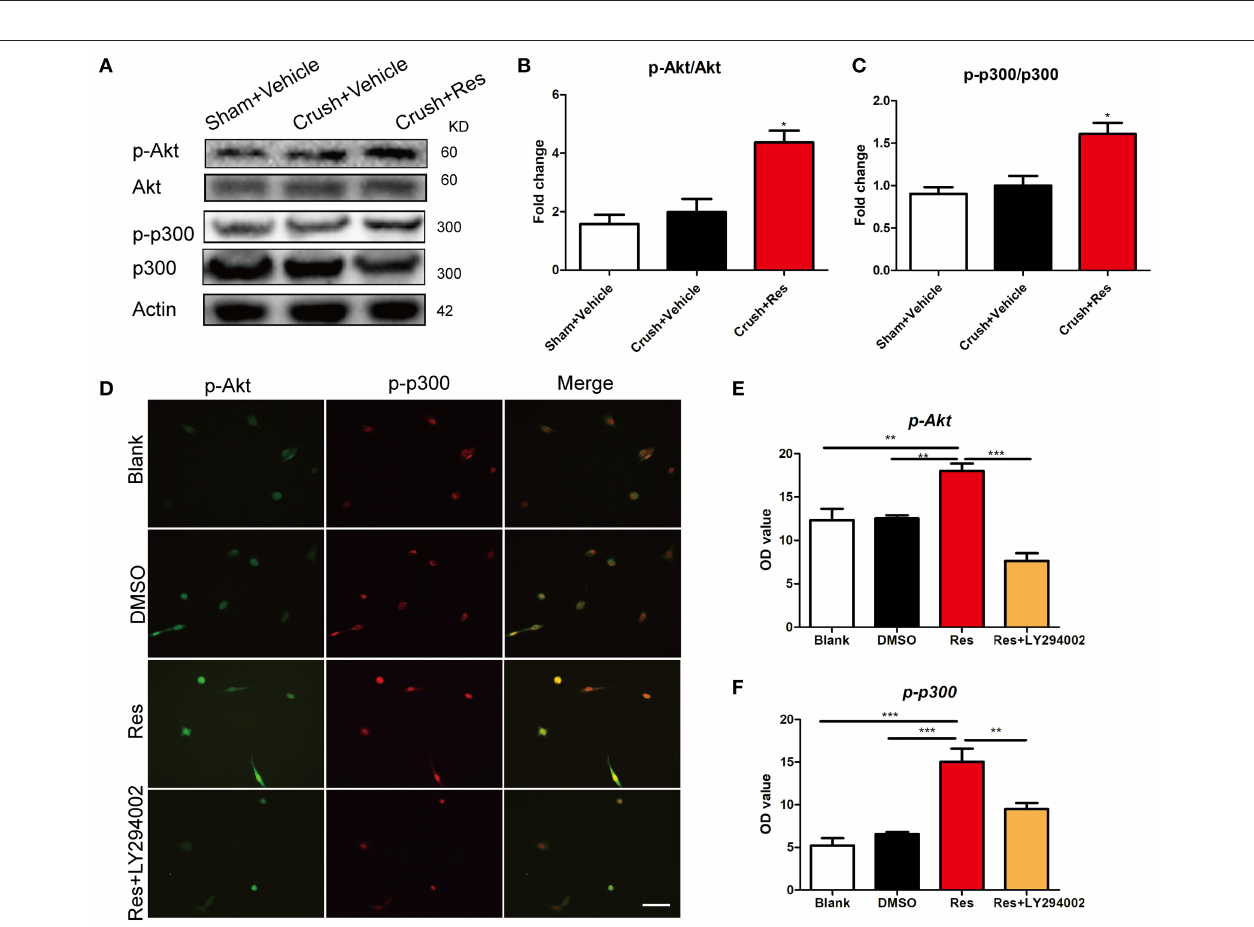
FIGURE 3 | Resveratrol (Res) enhanced the phosphorylation of Akt (p-Akt) and p300 (p-p300) in rat ventral spinal cord (A–C) and the inhibition of p-Akt suppressed the Res-induced expression of p-p300 in differentiated PC-12 cells (D–F) . (A) The representative protein bands showed the expression of p-Akt, Akt, p-p300 and p300 in rat ventral spinal cord. (B) Res (200 mg/Kg) increased the ratio of p-Akt to Akt in rat ventral spinal cord (Crush + Res vs. Crush + Vehicle, * P < 0.05 . n = 8 for each group). (C) Res (200 mg/Kg) increased the ratio of p-p300 to p300 in rat ventral spinal cord (Crush + Res vs. Crush + Vehicle, * P < 0.05. n = 8 for each group). (D) Representative images showing the co-labeling of p-Akt and p-p300 in differentiated PC-12 cells. Scale bar = 50 µ m. (E) LY294002, an inhibitor of Akt signaling, suppressed the Res-induced immuno intensity of p-Akt in differentiated PC-12 cells. (compared with Res treated cells, ** P < 0.01 , *** P < 0.01 ). (F) LY294002 suppressed the Res-induced immuno intensity of p-p300 in differentiated PC-12 cells. (compared with Res treated cells, ** P < 0.01 , *** P < 0.01 ).